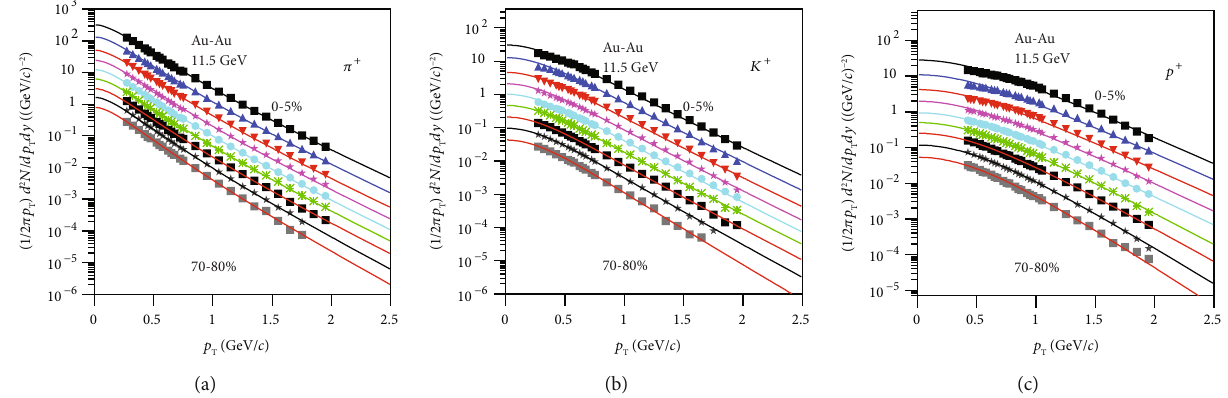
ffiffiffiffiffiffiffiffiffiffiffiffiffiffiffiffiffiffiffiffiffiffi p GeV . s NN = 11 : 5